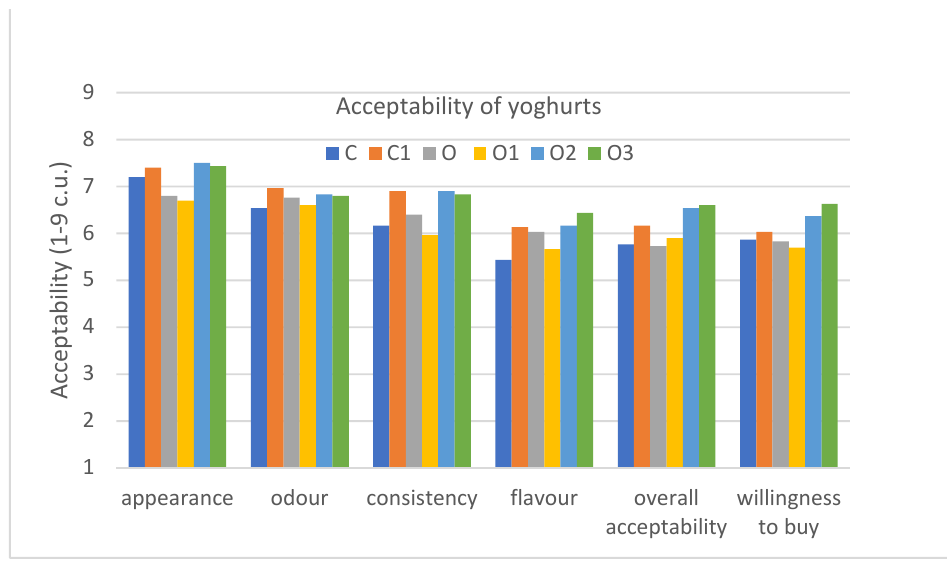
Figure 6. Graph of acceptability of the following six analysed yoghurts: C, control; C1, control with 6% inulin; O, oolong tea; O1, oolong tea with 3% inulin; O2, oolong tea with 6% inulin; O3, oolong tea with 9% inulin (the samples were not statistically different at p ≤ 0.05). When evaluating the acceptability of the consistency of the evaluated yoghurts, it can be seen that the samples with the addition of inulin at the levels of 6 and 9% were